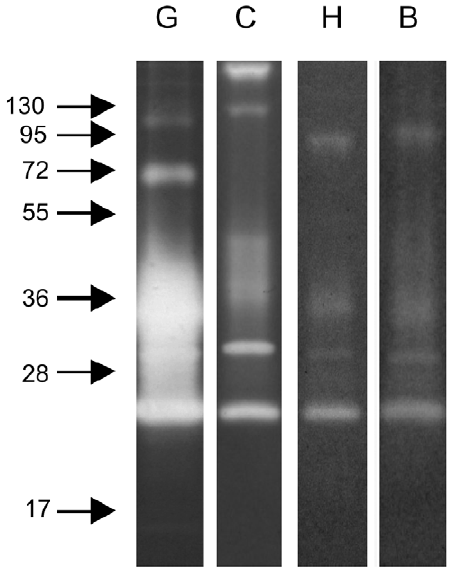
Figure 5. Zymography performed with gels co-polymerized incubated at pH 8 with different protein substrates. G : gelatin; C : casein; H : hemoglobin; B : BSA. Samples corresponding to 1/50 of 1 insect midgut obtained at 12 h ABF were loaded in lanes G and C , and 1/10 of 1 insect midgut obtained at 12 h ABF in lanes H and B . Molecular mass standard values (kDa) are indicated by numbers and arrows on the left side of the figure.